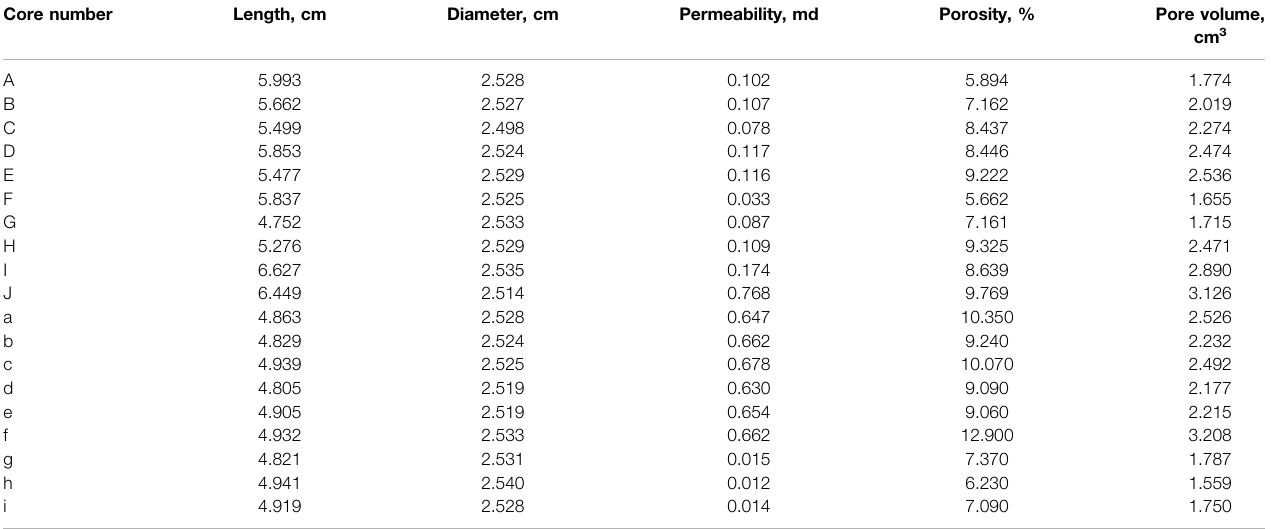
TABLE 1 | Physical parameters of cores.